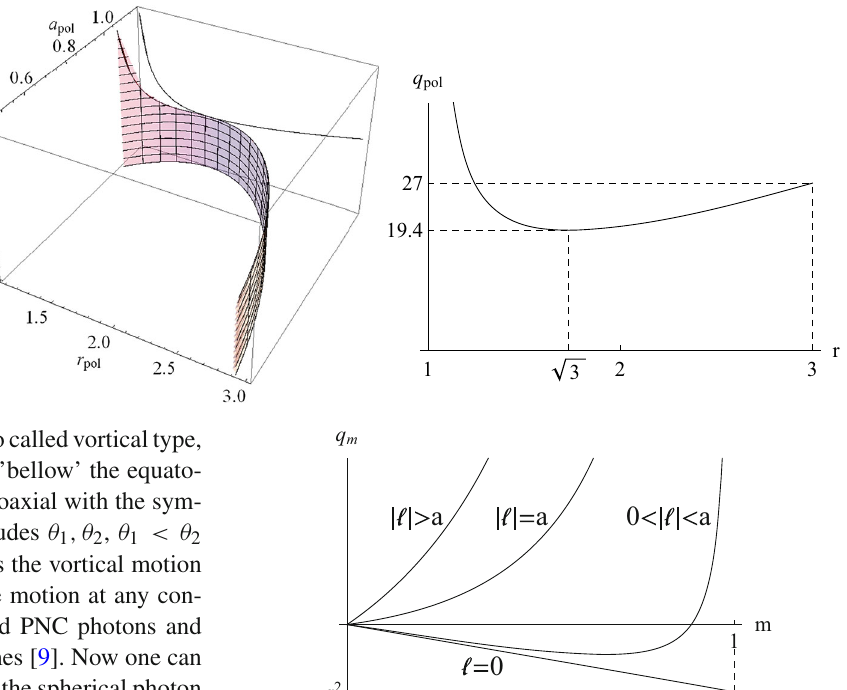
Fig. 3 Dependence of the parameter q pol of the polar spherical orbits on its radii r pol depicted with corresponding dimensionless spin a pol (left) and its projection q pol ( r pol ) onto the ( r − q ) plane (right)